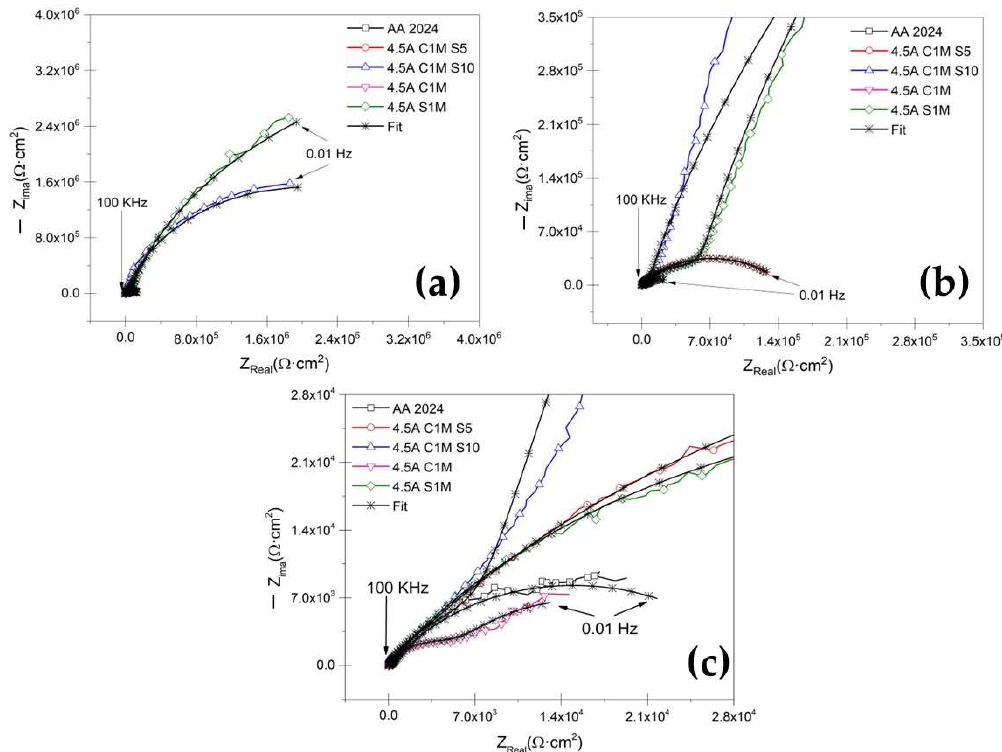
Figure 10. Nyquist plot for un-anodized AA2024 and citric–sulfuric acid-anodized samples immersed in NaCl solution. ( a ) i = 4.5 A/dm 2 , ( b ) first zoom of i = 4.5 A/dm 2 , and ( c ) second zoom of i = 4.5 A/dm 2 .